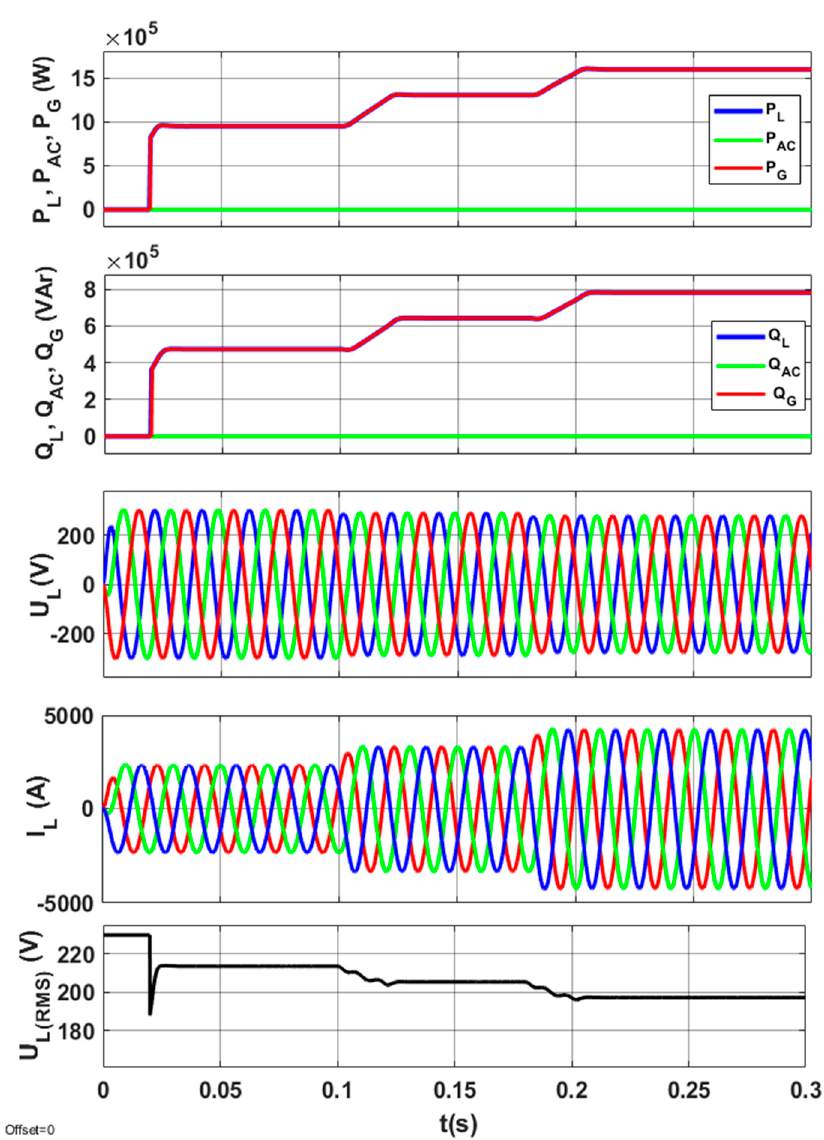
Figure 13. Energy and electromagnetic processes without AC operation: waveforms of active power on the load, generator, and AC ( P L , P G , P AC ); reactive power on the load, generator, and AC ( Q L , Q G , P AC ); and voltage on the load ( U L ).